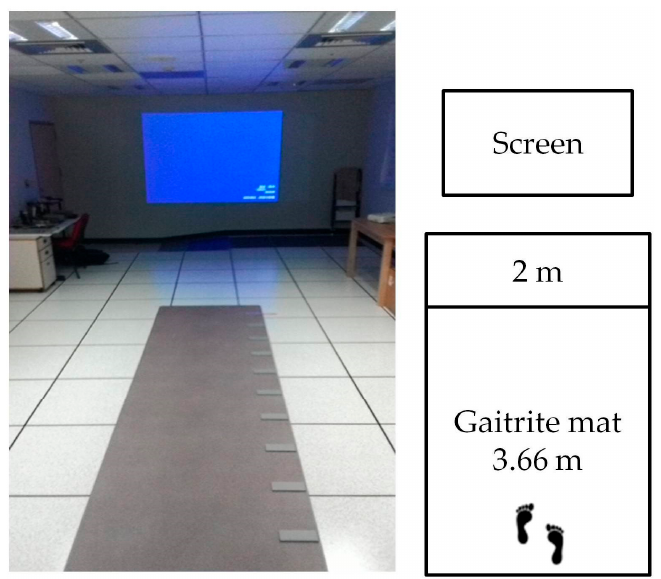
Figure 1. Experimental environment settings.